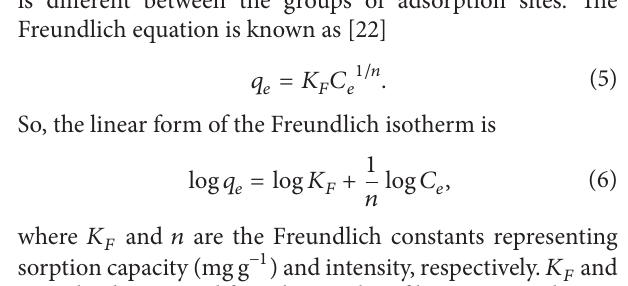
volume of the solution, and 𝑊 (g) is the mass of adsorbent used. Langmuir and Freundlich adsorption isotherms were used to describe the equilibrium characteristics of adsorp-